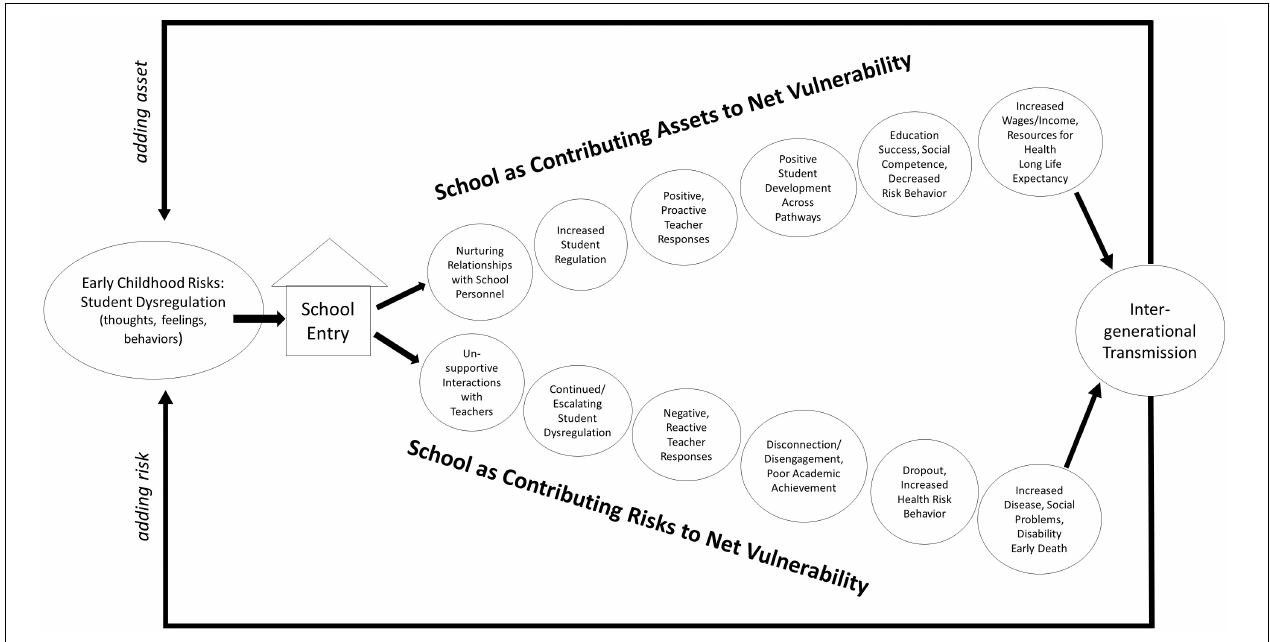
FIGURE 1 | Illustration of developmental cascades: School as an asset or risk to net vulnerability.